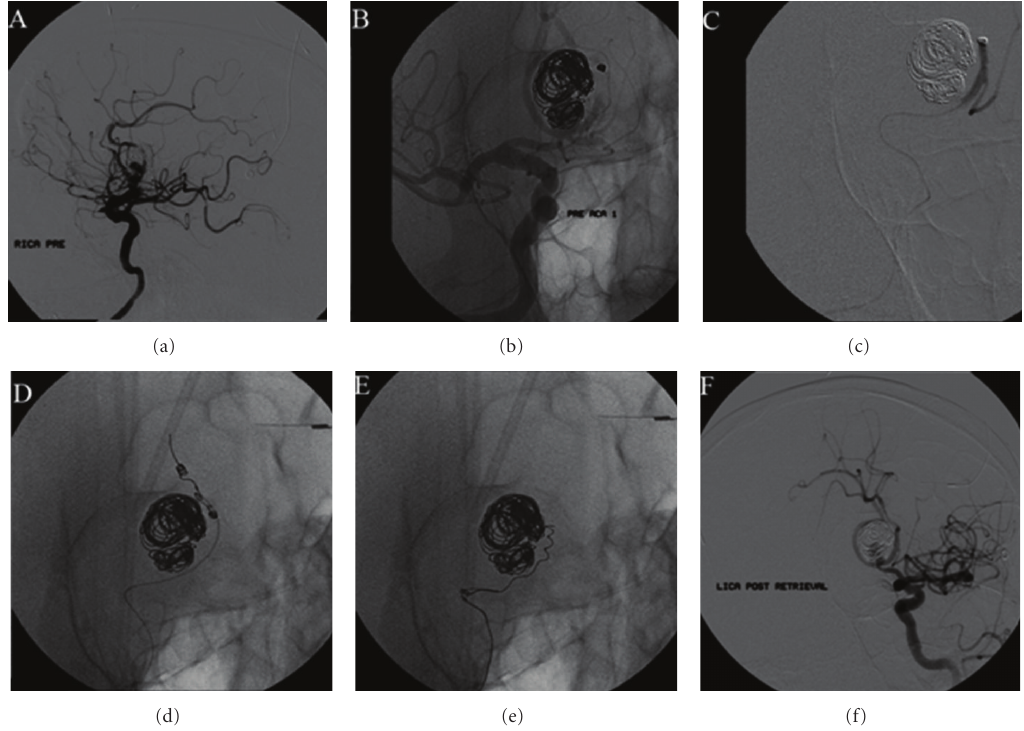
Figure 3: (a) Lateral view of left carotid injection demonstrates recanalization of the previously coiled ACOM aneurysm. (b) Nonsubtracted angiogram at the working view shows the dislodged coil in the left A2 segment. (c) Superselective injection demonstrates that no distal flow passes the migrated coil. (d) Plain X-ray demonstrating the Merci device passing the coil obstruction. (e) The Merci device ensnares the migrated coil. (f) Postretrieval angiogram shows reconstitution of distal left A2